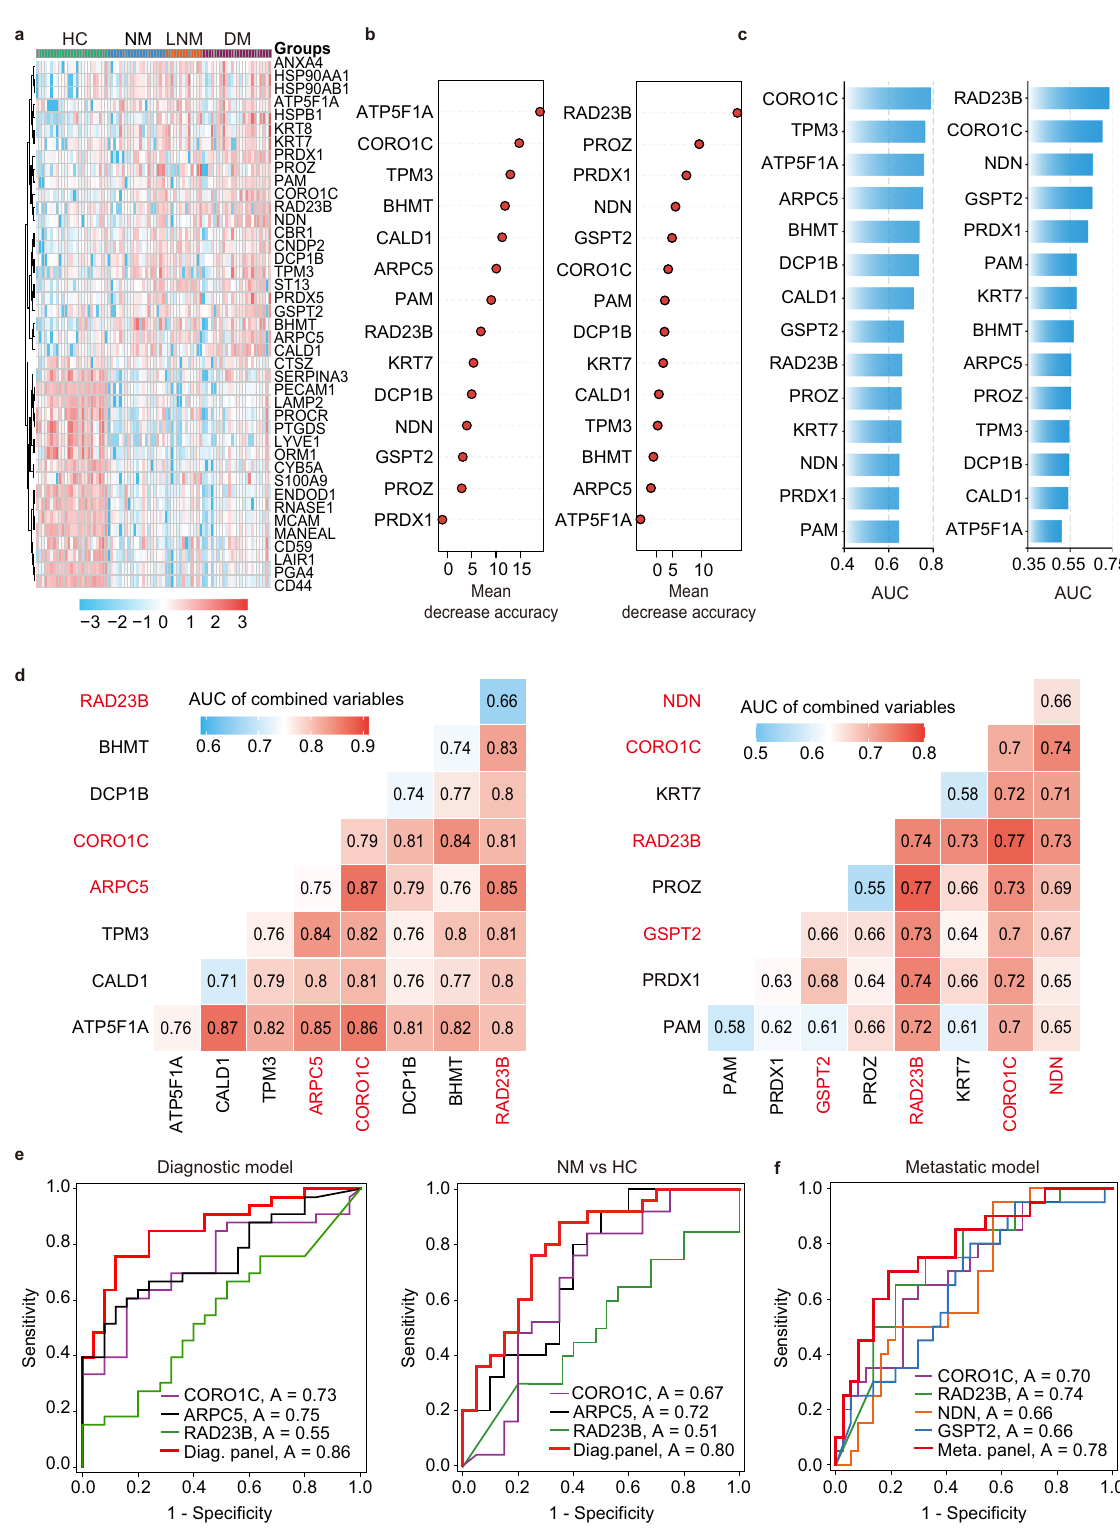
model, the combined signature with FIT led to a sensitivity and speci fi city of 81.8% and 94.1% in the training set and 93.8% and 86.4% in the validation set (Supplementary Table 5, Fig. 4e-upper, Supplementary Fig. 3c). In the metastatic model, the combined signature with serum CEA yielded a sensitivity and speci fi city of 71.8% and 75.6% (Supplementary Table 6 and Fig. 4e-bottom). The panel achieved higher sensitivity than the use of a single